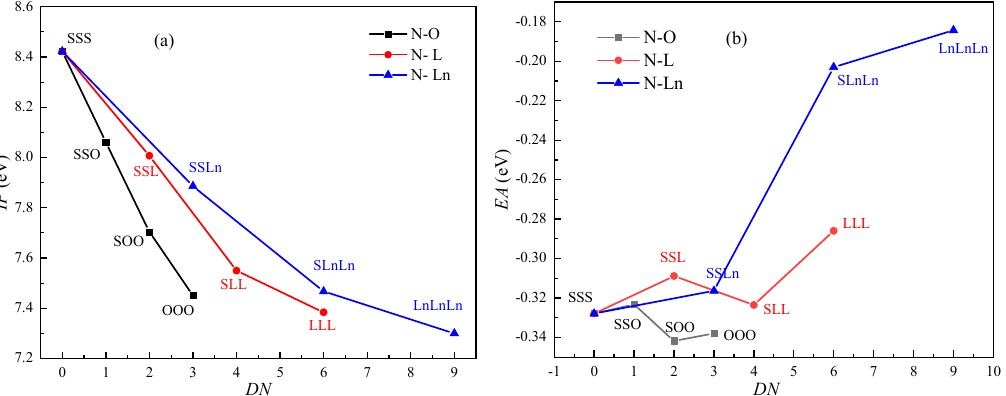
Figure 1. E ff ect of C = C on the ionization potential ( IP ) and electron a ffi nity ( EA ) of triglycerides ( DN : Figure 1. Effect of C=C on the ionization potential ( IP ) and electron affinity ( EA ) of triglycerides ( DN : the number of C = C): ( a ) IP ; ( b ) EA the number of C=C): ( a ) IP ; ( b ) EA .